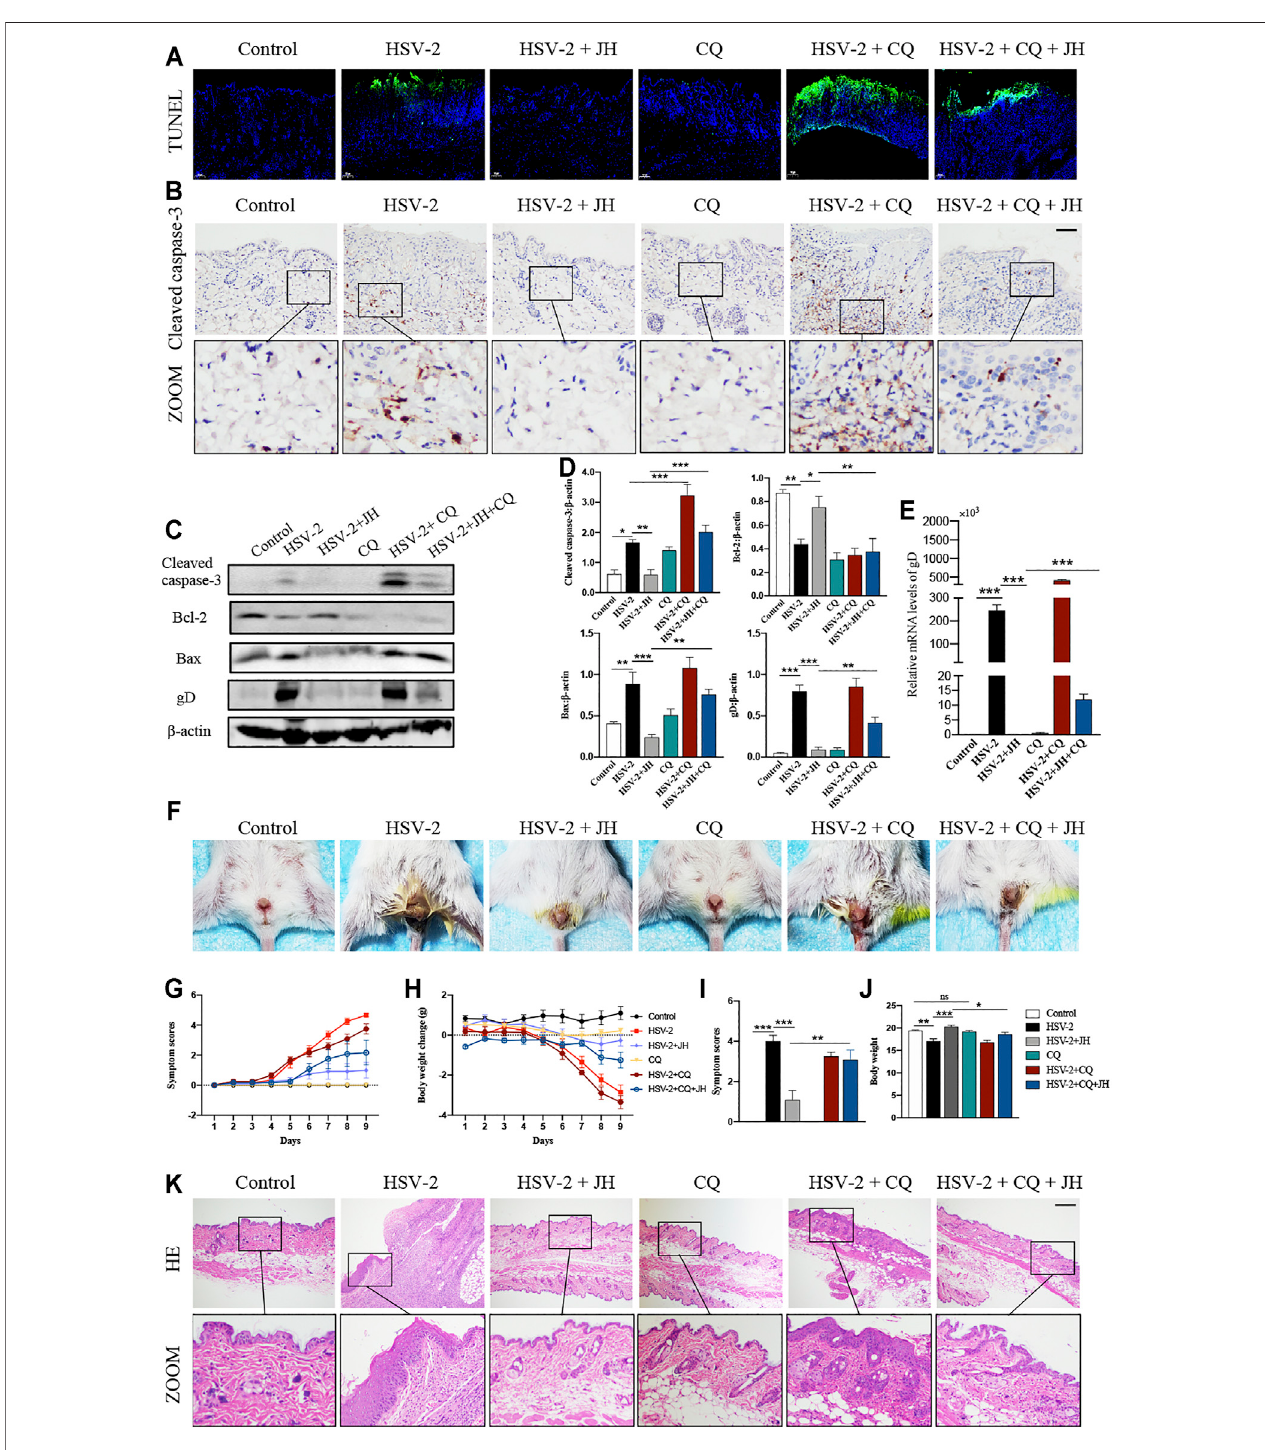
FIGURE 6 | The anti-apoptotic effect of JZ-1 is mediated by its induction of autophagy. (A) Representative TUNEL staining in vulva of different groups. (B) Representativeimmunohistochemistrystainingforcleavedcaspase-3invulvaofdifferentgroups. (C) Representativewesternblotsforcleavedcaspase-3,BaxandgDin vulvaofdifferentgroups. (D) Thequanti fi cationofcleavedcaspase-3,BaxandgDwesternblots. (E) ThemRNAlevelsofgDinvulvaofdifferentgroups. (F) Picturesofthe vulvaofbalb/cmice. (G) Symptomscoresofdifferentgroups. (H) Bodyweightofdifferentgroups. (I – J) StatisticalanalysisofsymptomscoresNDBodyweight. (K) Representative liver H&E staining of different groups. All data are presented as means ± SEM. p < 0.01 (**), and p < 0.001 (***); ( n (cid:2) 6).